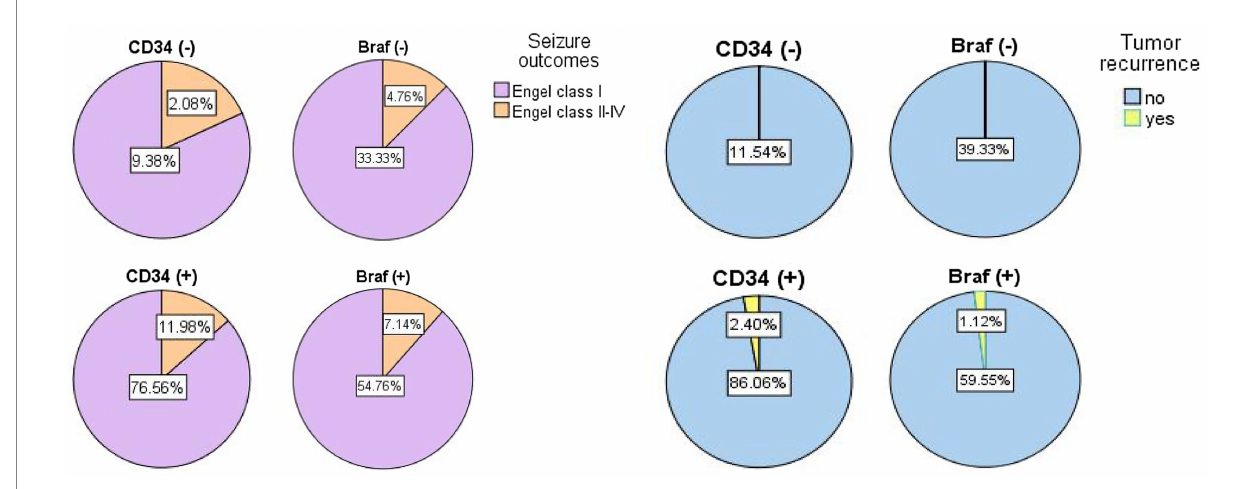
FIGURE 3 The pie graphs showing the percentages of prognostic results in seizure outcomes (left) and tumor recurrence (right) based on differential diagnosis of gangliogliomas with CD34 expression or with BRAF V600E